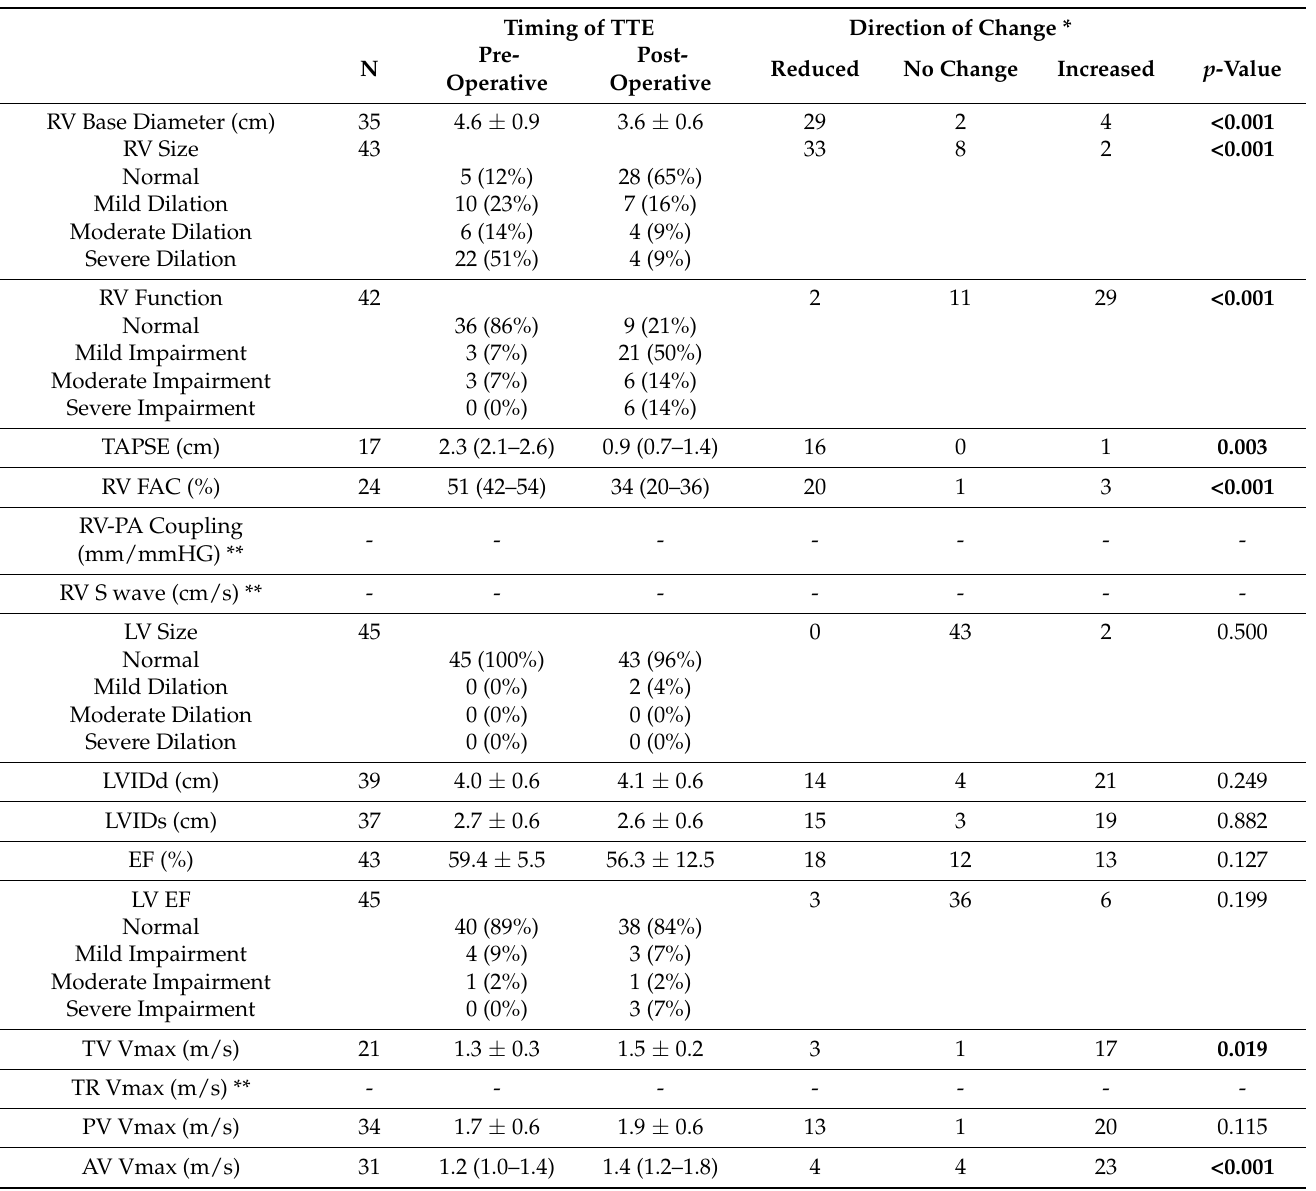
Table 4. Changes in TTE Parameters Between the Pre- and Postoperative Scans. Timing of